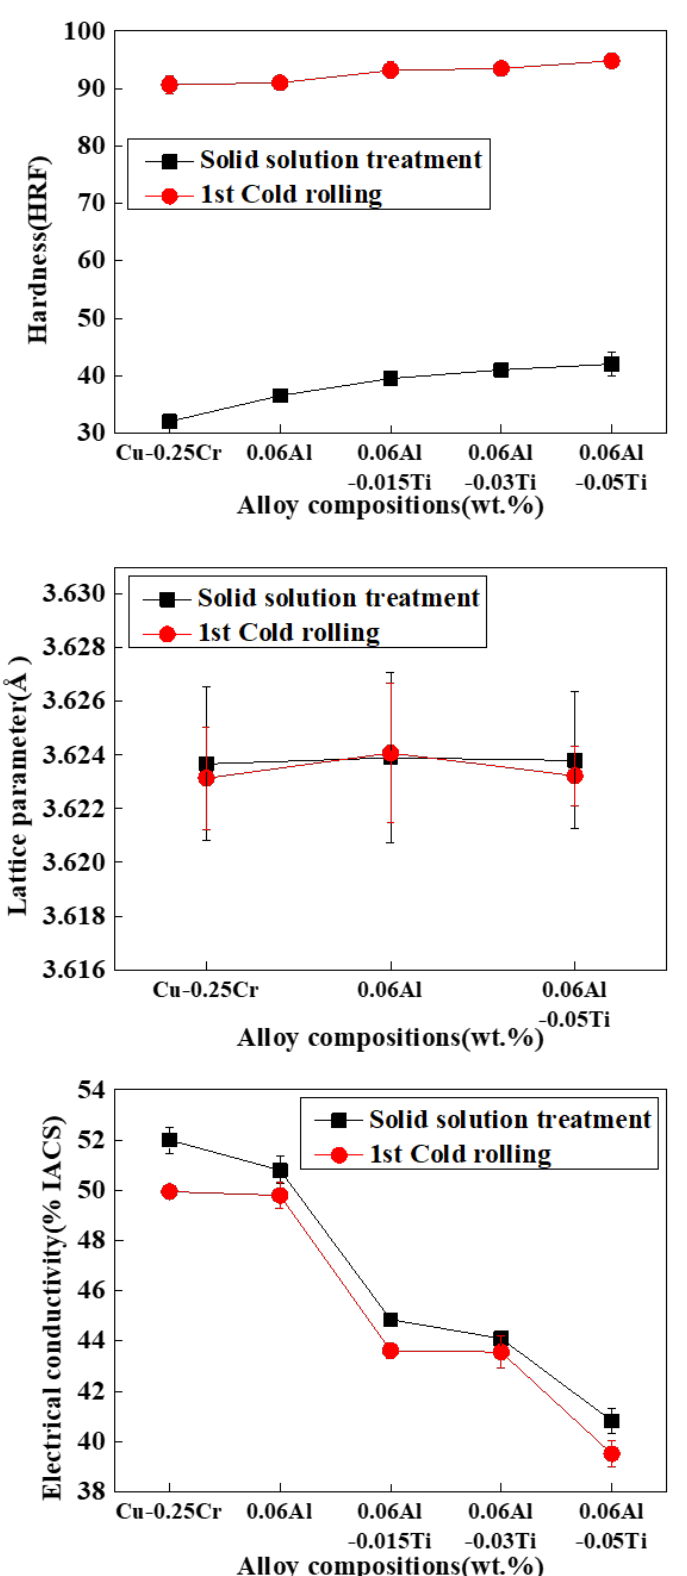
Figure 6. Electrical and mechanical properties and lattice parameter variation after 1st cold-rolled Cu-Cr alloys.